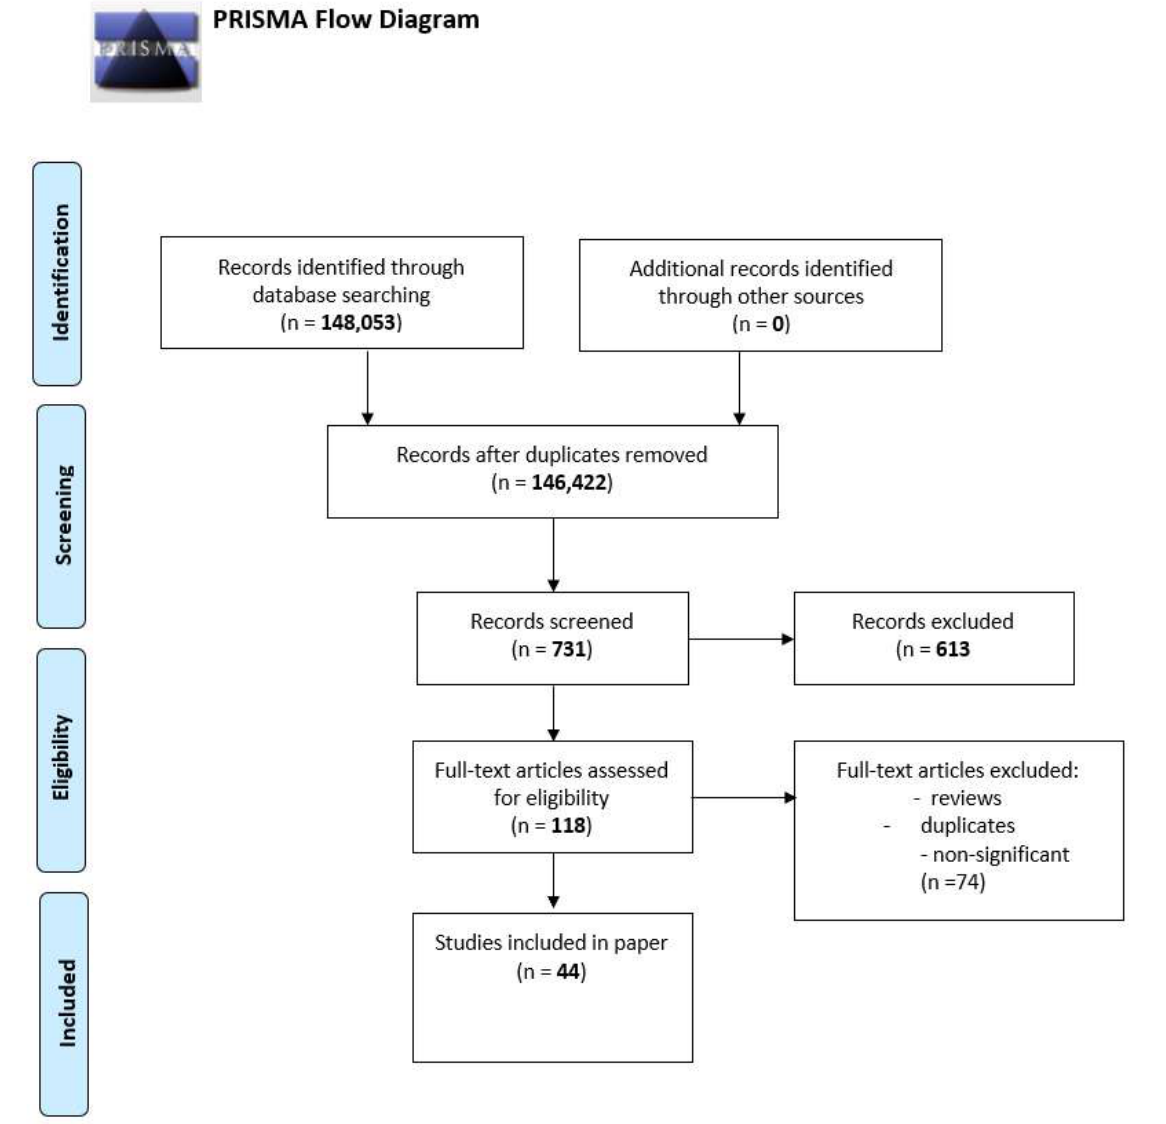
Figure 2. The PRISMA Flow Diagram.